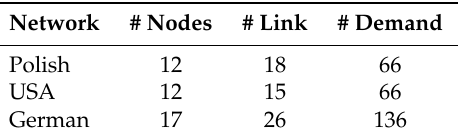
Table 1. Analyzed network